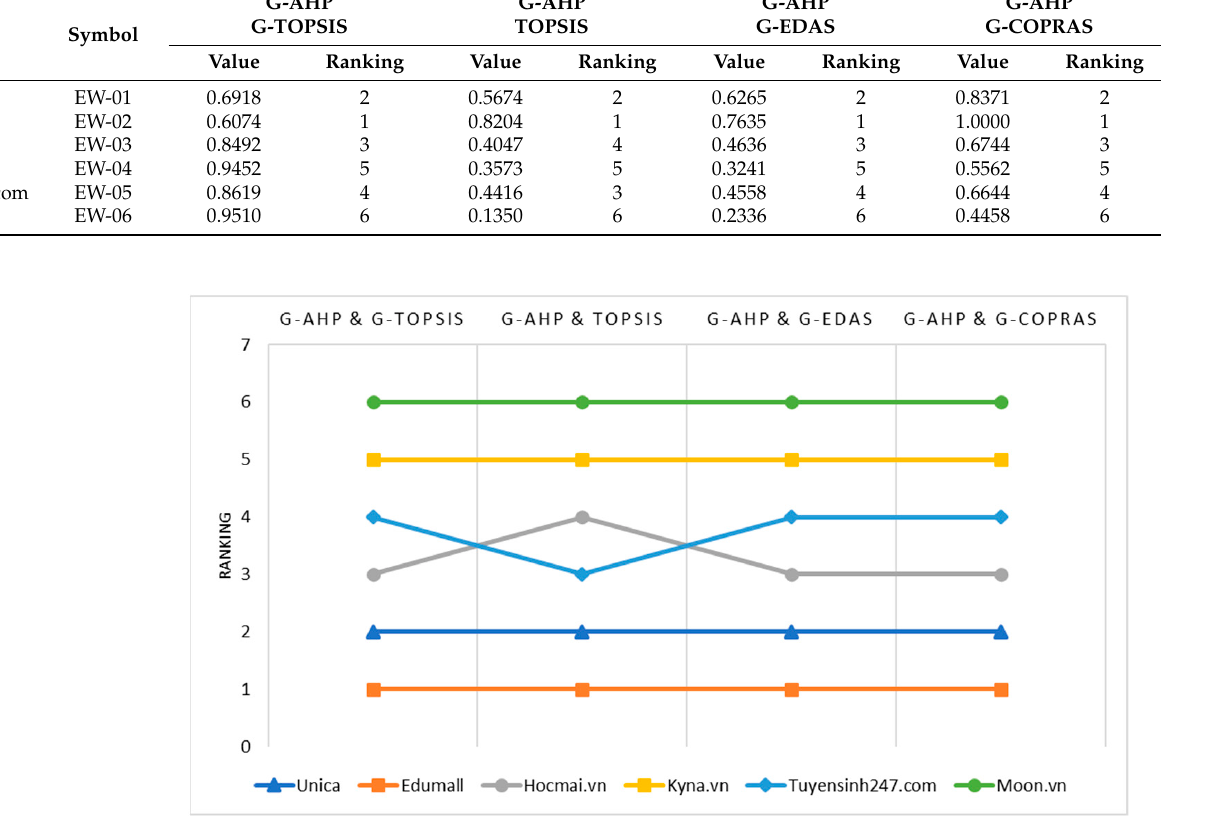
Figure 6. Ranking results of the compared methods.